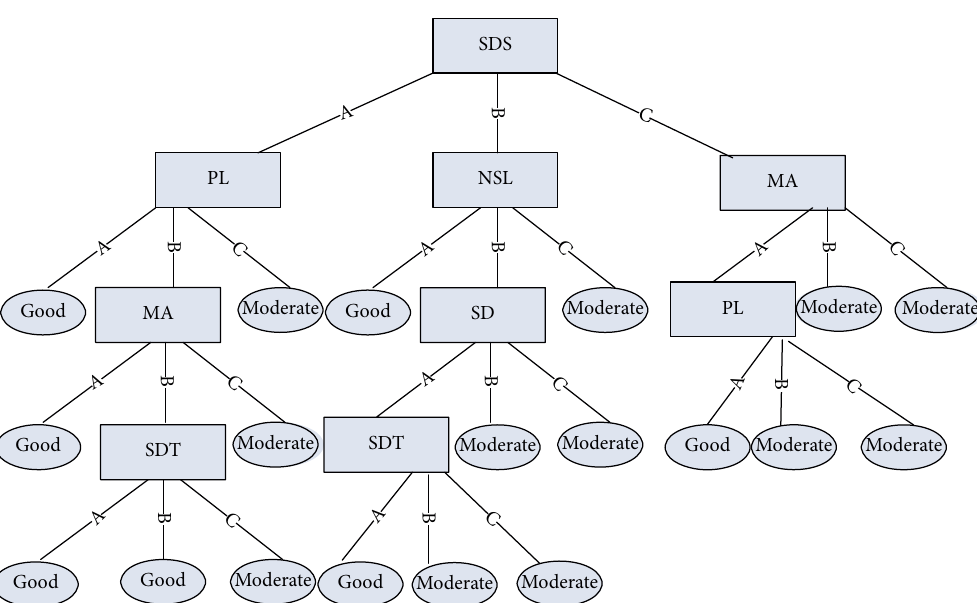
Figure 4: Decision tree by using ID3